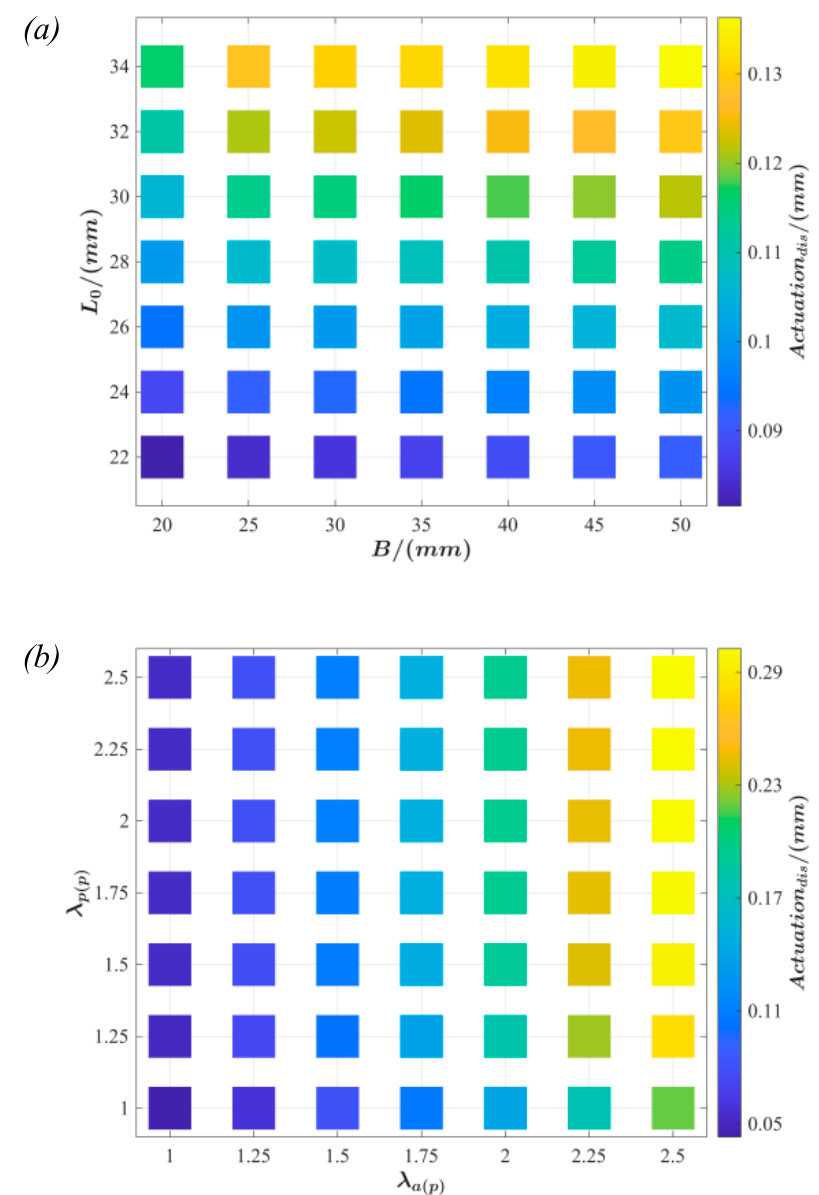
Figure 4. The influence of key design parameters on the actuation performance of the push-pull DEA: ( a ) the actuation performance of the push-pull DEA with the L 0 and B parameters; ( b ) the actuation performance of the actuator by combination of λ a ( p ) and λ p ( p )